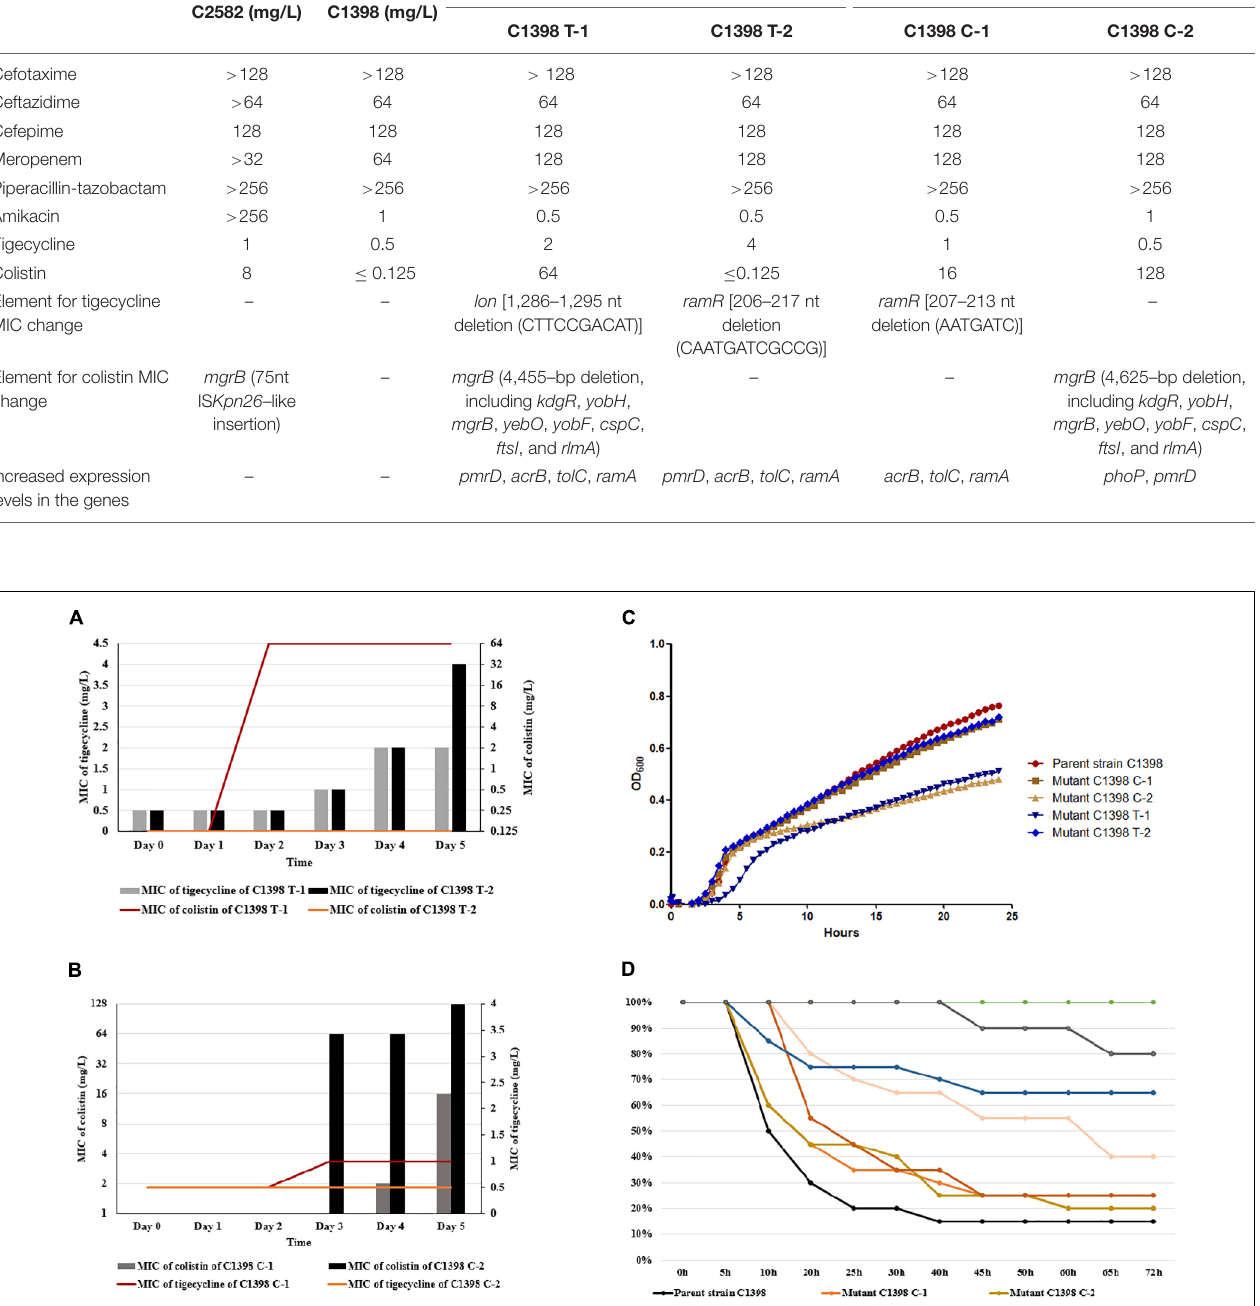
Frontiers in Microbiology |